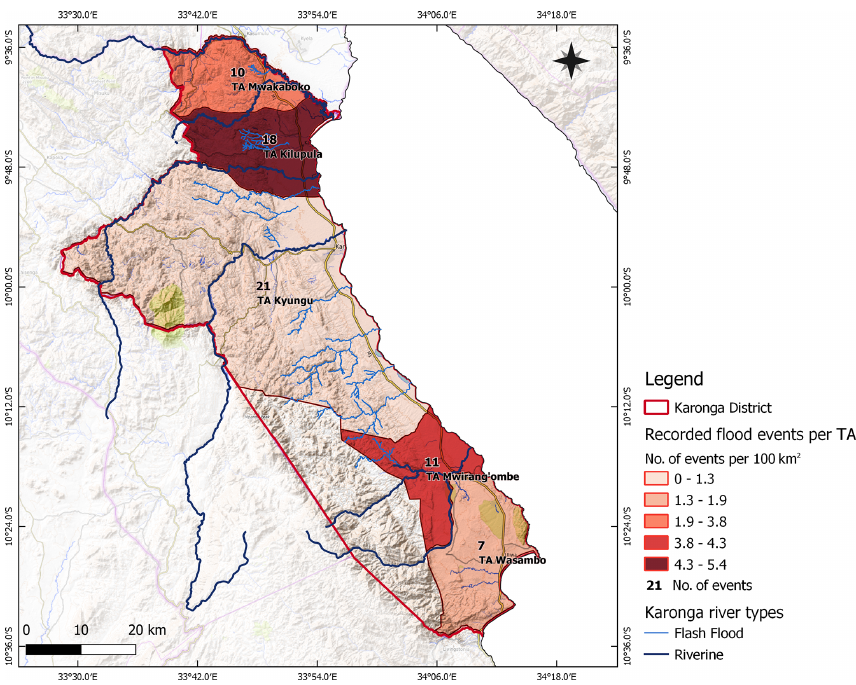
Figure 3. Number of recorded flood events per 100km 2 for every TA (collected for the period 2000–2018), with the total number of events recorded for each TA indicated as